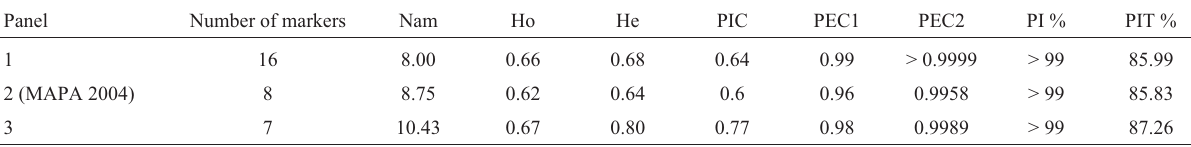
Table 3 - Genetic variability parameters estimated for three different microsatellite panels used in goats sampled in